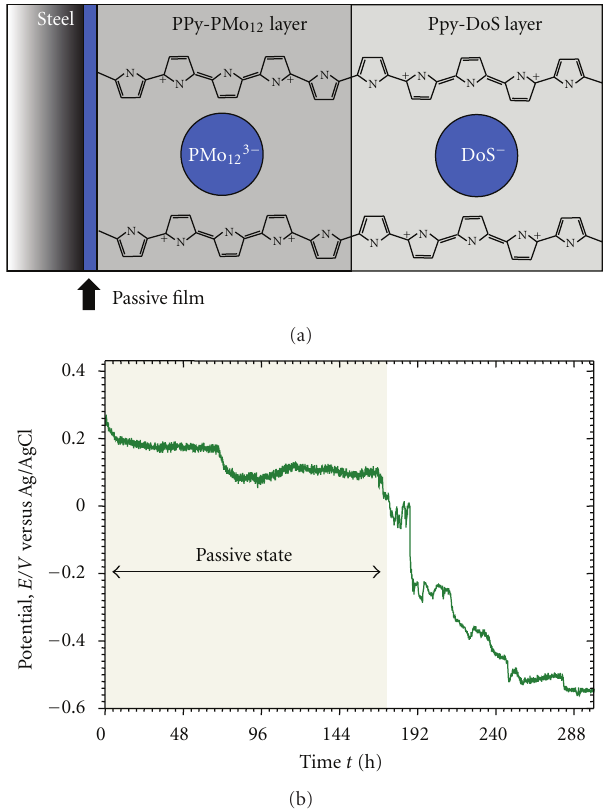
Figure 8: Model of bilayered PPy film and transient of open circuit potential of steel covered by the bilayered PPy in 3.5% NaCl solu- tion.